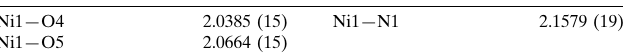
Selected bond lengths (A˚ ).